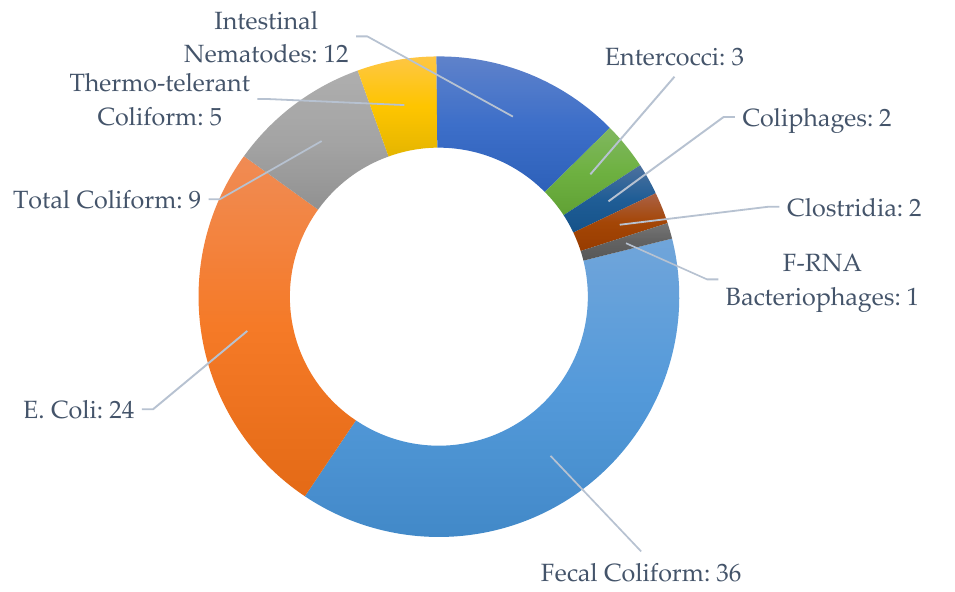
Figure 6. The number of regulations and guidelines which indicated different indicator microorganisms.